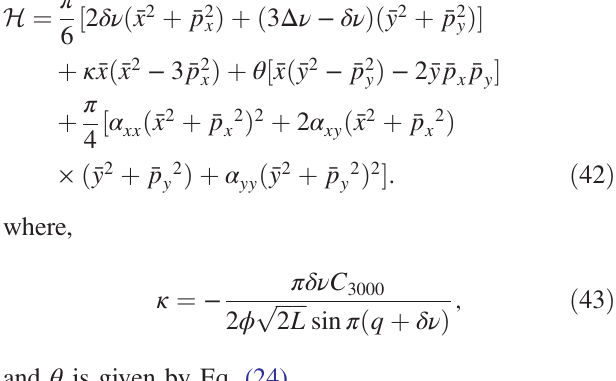
FIG. 17. A set of invariant tori in the nonlinear normalized 4D phase spaces on the resonance 3 ν 2 = 3 and ν 1 = 6 Þ þ 0 . 005 . The red dots represent the transformed periodic orbits from tracking and the blue lines are the with ν x ¼ y ¼ ð numerical solution in Eq. (42).